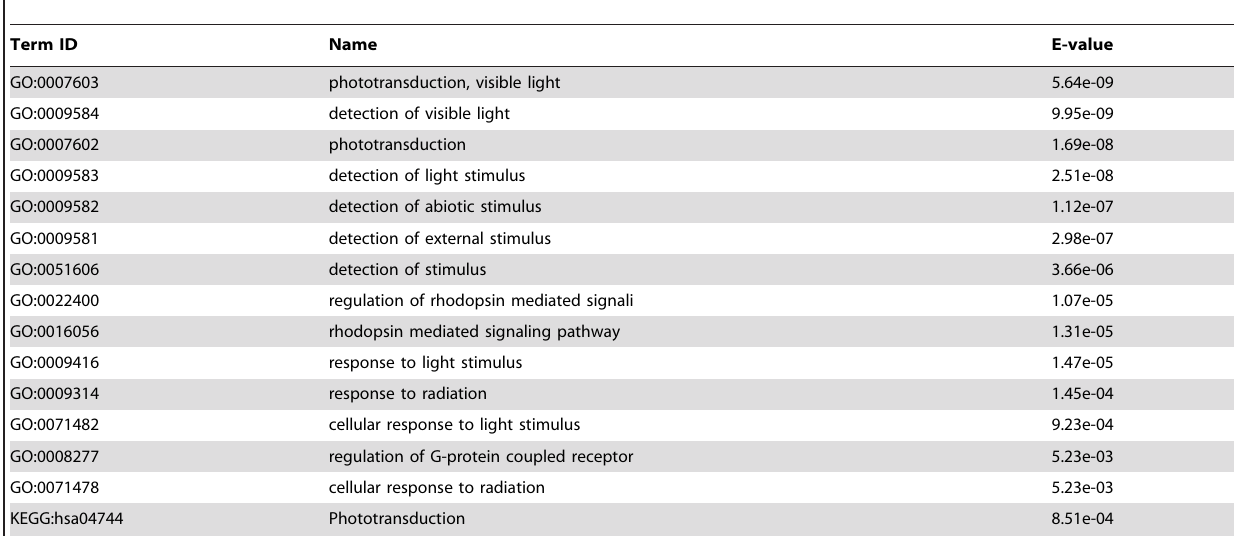
Table 3. Terms associated with the cluster with the highest probability to include the Retinitis Pigmentosa type